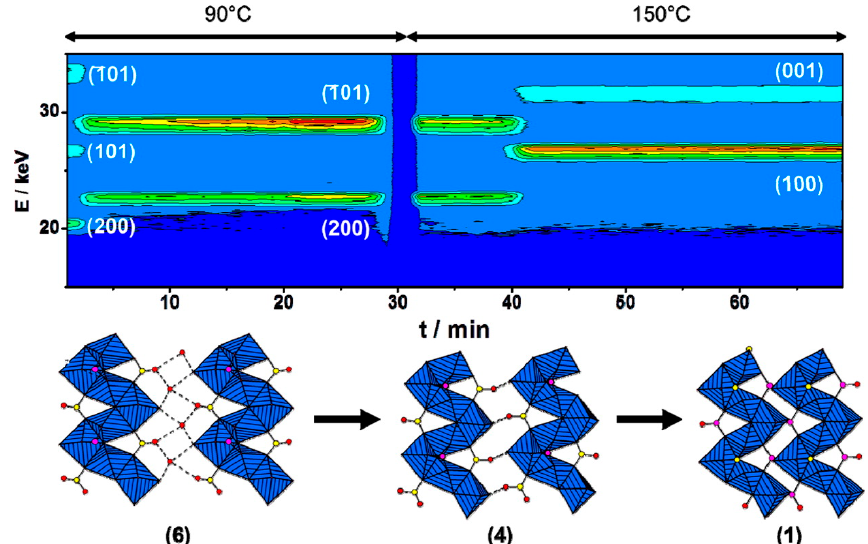
Figure 19. Illustration of the reaction pathway leading to the formation of [Cu 2 (O 3 PC 2 H 4 -SO 3 )(OH)(H 2 O)]·3H 2 O (1) through intermediates Cu 2 [(O 3 P–C 2 H 4 –SO 3 )(H 2 O) 2 (OH)]·4H 2 O (4) and [Cu 2 (O 3 P–C 2 H 4 –SO 3 )(H 2 O) 2 (OH)]·3H 2 O (6) . The phase transformation at different temperatures is shown in the contour plot (top), and the correlated structural motifs of the copper oxygen chains are presented at the bottom. The gap in the contour plot at ~30 min is due to the stage at which the specimen was removed from the vessel. Reprinted with permission from reference. [96]. Copyright 2012, American Chemical Society.